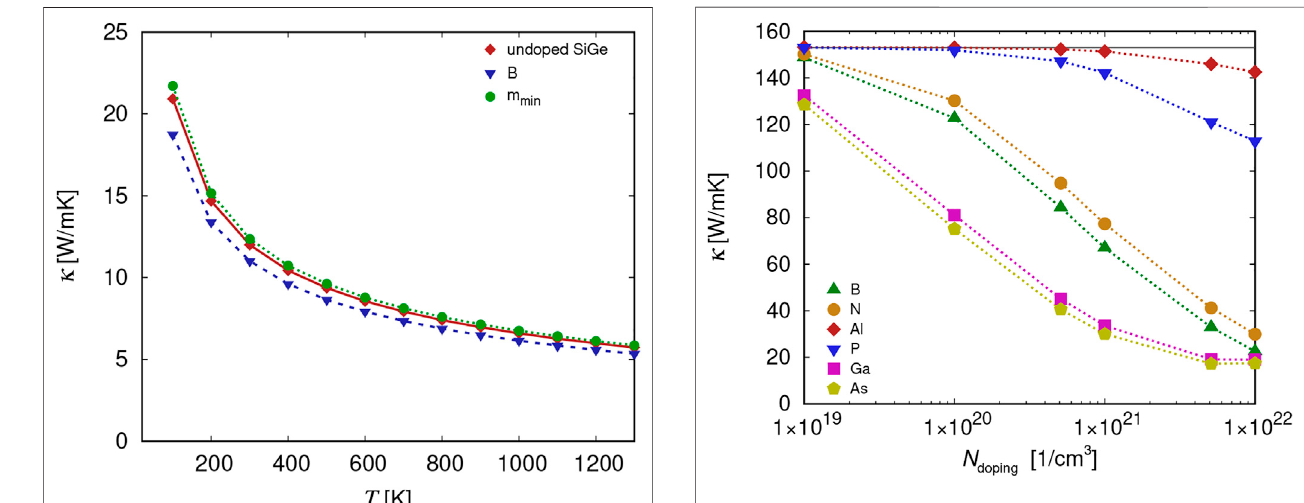
FIGURE 8 | Thermal conductivity in Si as a function of the doping level for variousdopants.ThehorizontalgraylineindicatesthethermalconductivityinpureSi.